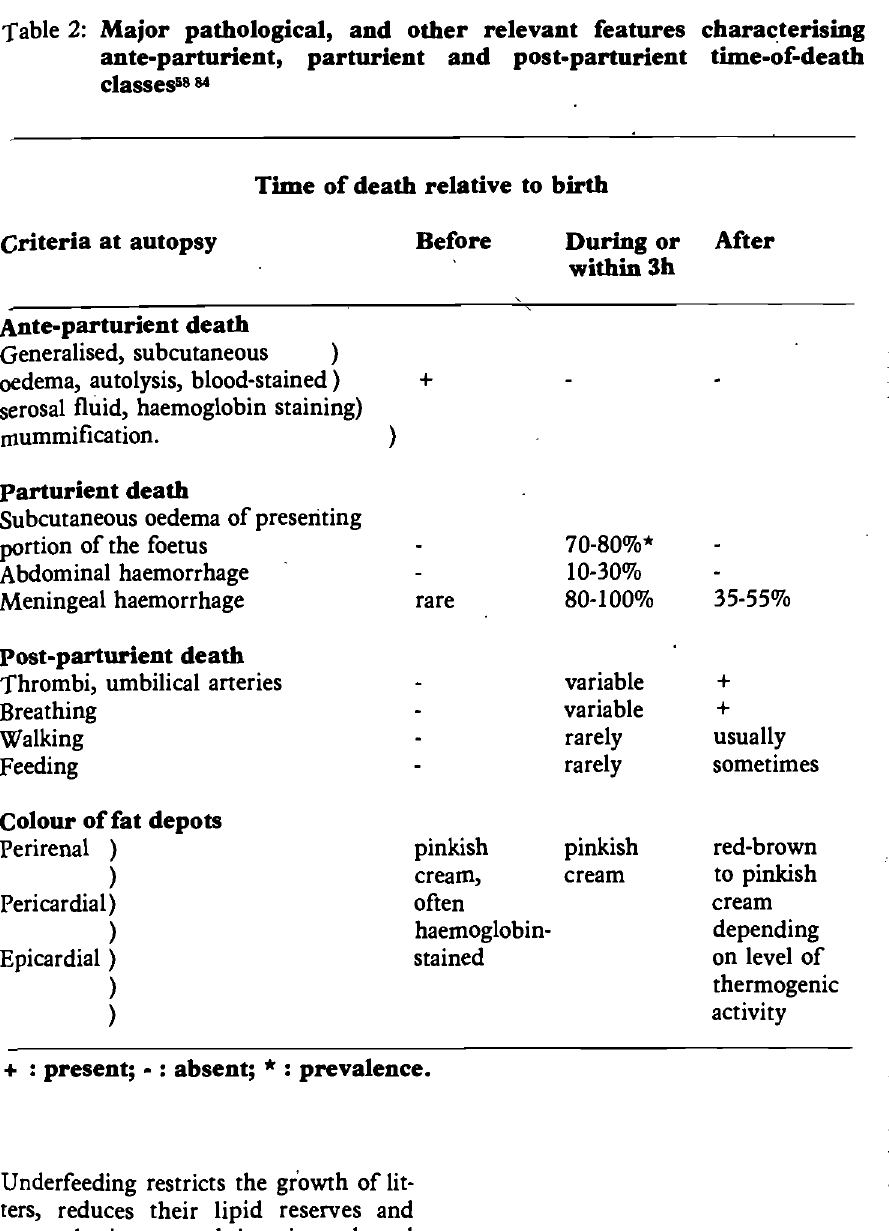
Table 3: Occurrence of major causes of death relative to time-of-death classification34 58